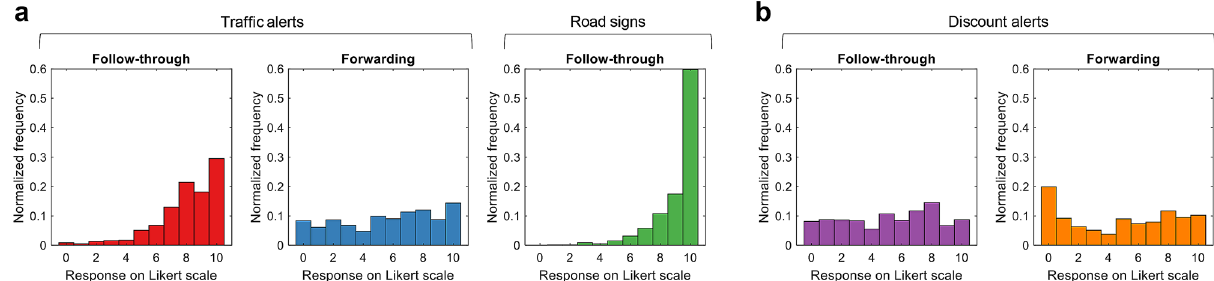
Figure 1. Assessing propensities to follow-through and forward disinformation. ( a ) Survey results for the divergence attack, represented as a normalized histogram summarizing the participants’ responses on a Likert scale from 0 to 10 indicating their propensity to follow-through on and forward fake traffic alerts ( n = 3301 ), and follow-through on fake road signs ( n = 1000 ). ( b ), The same as ( a ) but for convergence attacks via fake discount alerts ( n = 1000